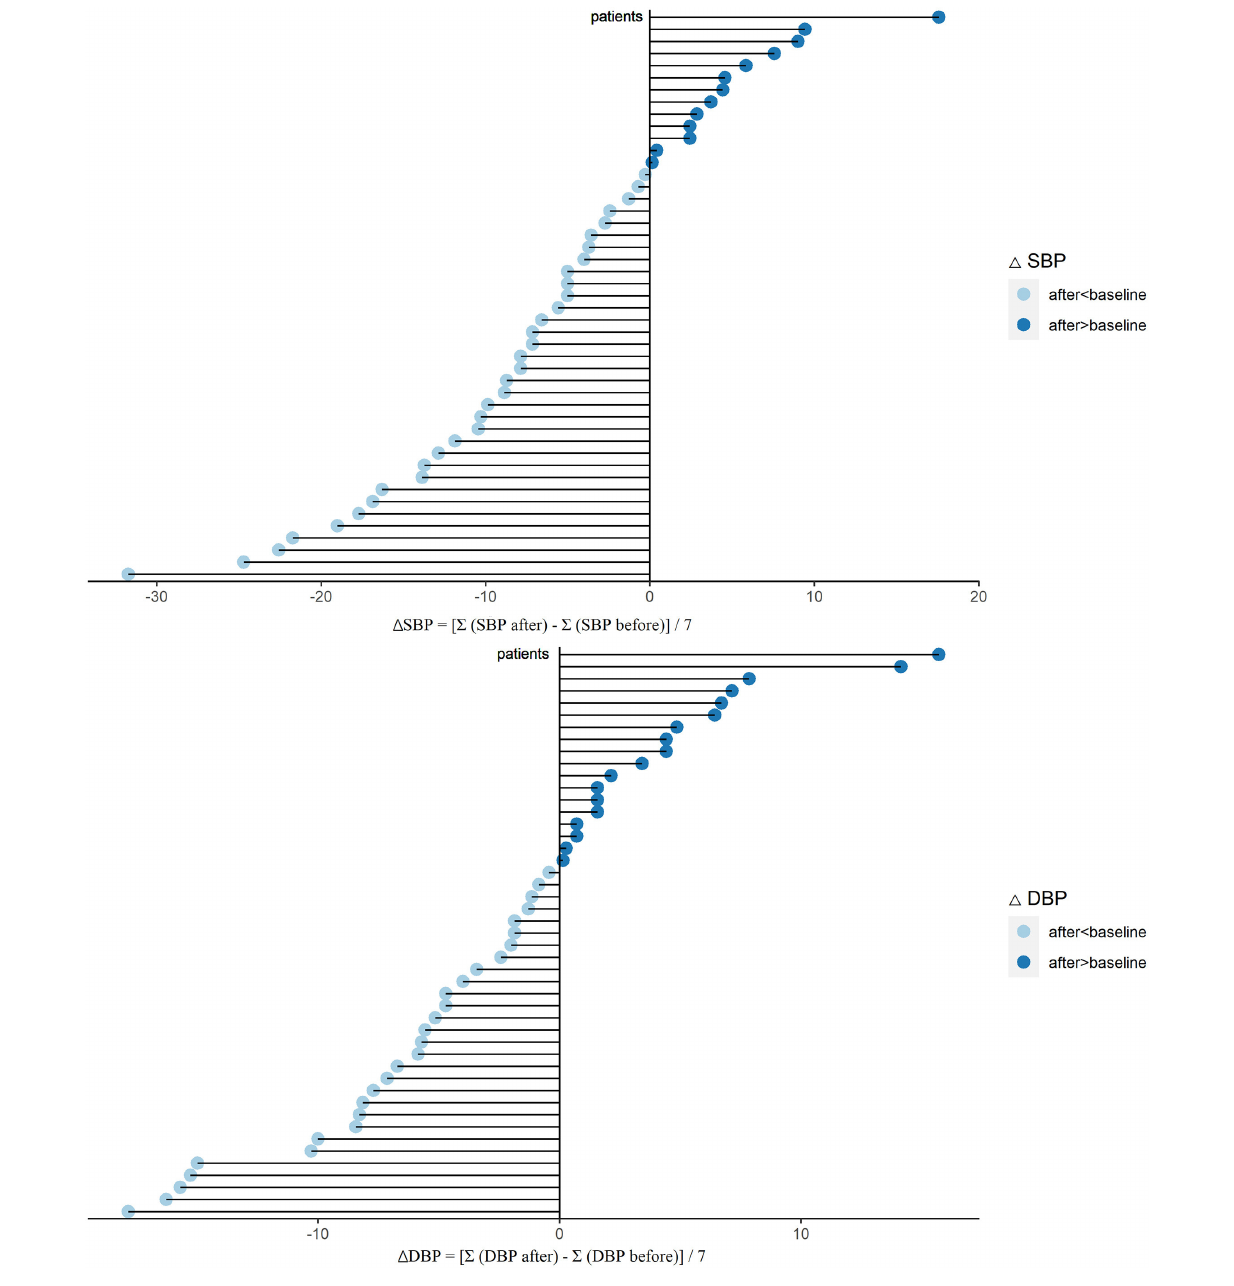
observation (only 7 days after applying sacubitril-valsartan) and relatively small sample size (47 participants). The real side effects of sacubitril-valsartan in PD patients should be fully evaluated in the subsequent longer-term and larger sample size